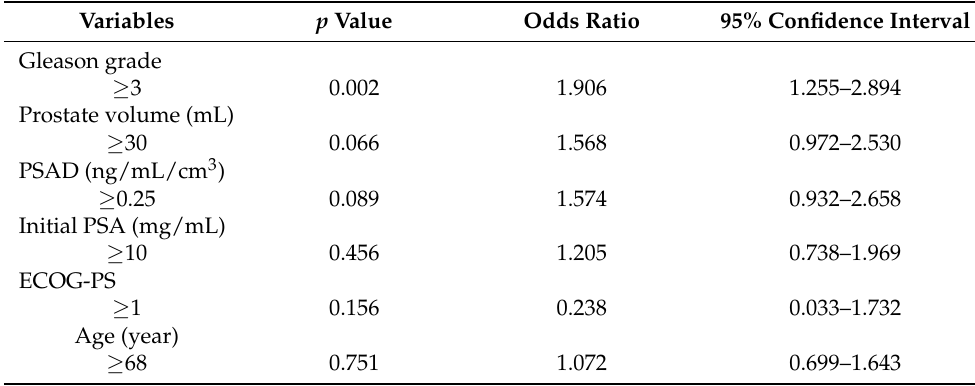
Table 2. Multivariate